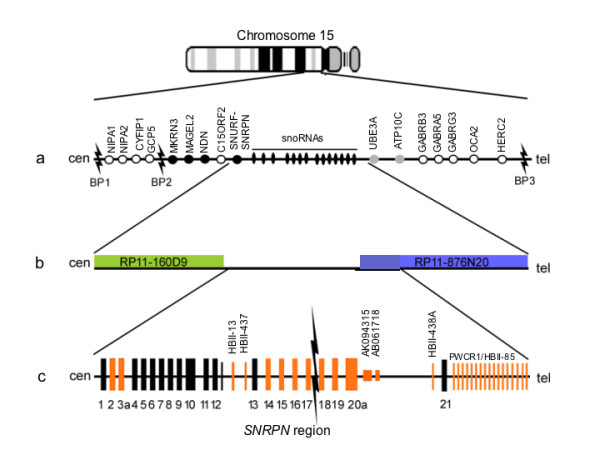
Mapping the t(4;15) breakpoint and expression patterns of SNRPN exons and intronic genes . a . Schematic map of human chromosome region 15q11-q13. Black and gray circles represent imprinted genes, expressed from the paternal or maternal allele, respectively. White circles designate bi-allelically expressed genes. BP1, 2, and 3 indicate the locations of the deletion breakpoint hotspots [43]. b . FISH results placed BAC RP11-160D9 highlighted in green (nucleotide position 22577151-22735621) proximal to the translocation breakpoint and RP11-876N20 highlighted in blue (position 22857334-23036552) distal to the breakpoint. Intron 17, comprising nucleotides 22795282 to 22811656, thus is located ~ 63.4 kb downstream of RP11-160D9 and ~ 42 kb upstream of RP11-876N20. c . On representation of the SNRPN region (not drawn to scale) boxes represent exons and ESTs, lines represent snoRNA copies. Orange boxes and lines indicate exons, ESTs or snoRNAs tested for expression either by RT-PCR or quantitative RT-PCR. Black flash indicates the breakpoint in intron 17 of the SNRPN locus.